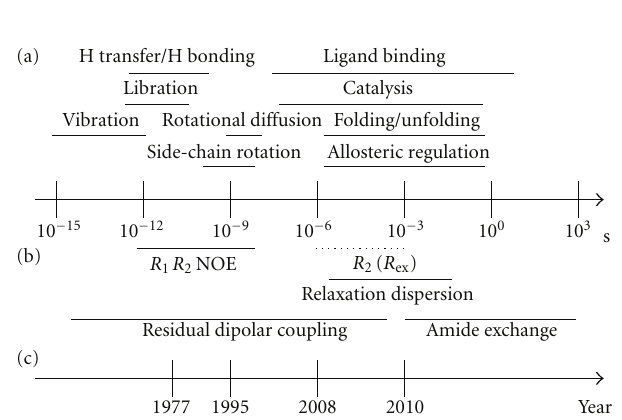
Figure 1: Timescales of protein motions (a) with timescales acces- sible to NMR experiments (b) and the approximate years these timescales became accessible to MD simulations